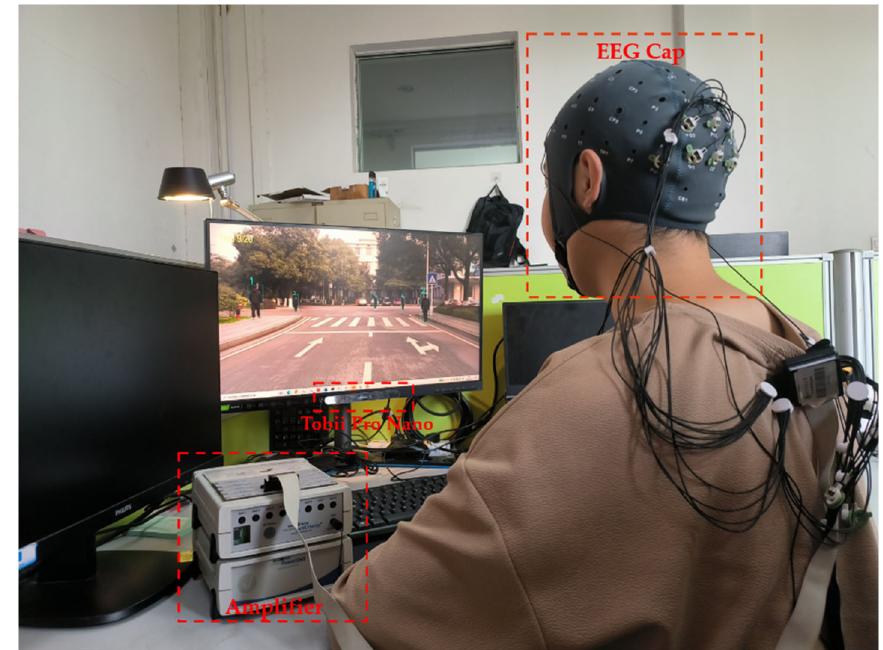
Figure 3. Placement of data acquisition equipment.